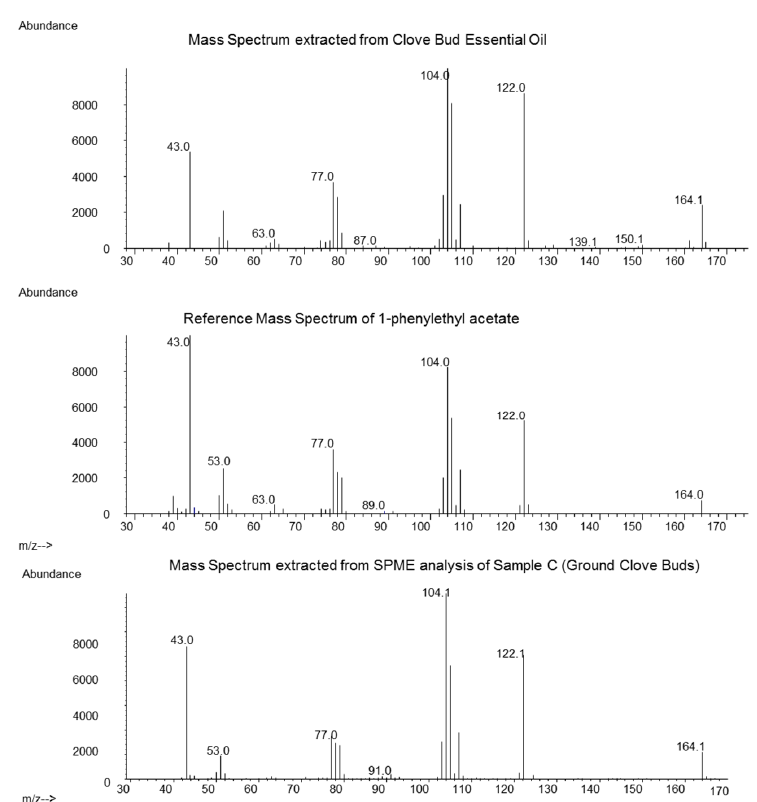
Figure 1. Comparison of the mass spectrum obtained from clove bud essential oil (top), reference mass spectrum from 1-phenylethyl acetate (1-PA) (middle) and solid phase micro extraction (SPME) of ground clove buds (sample C, bottom).